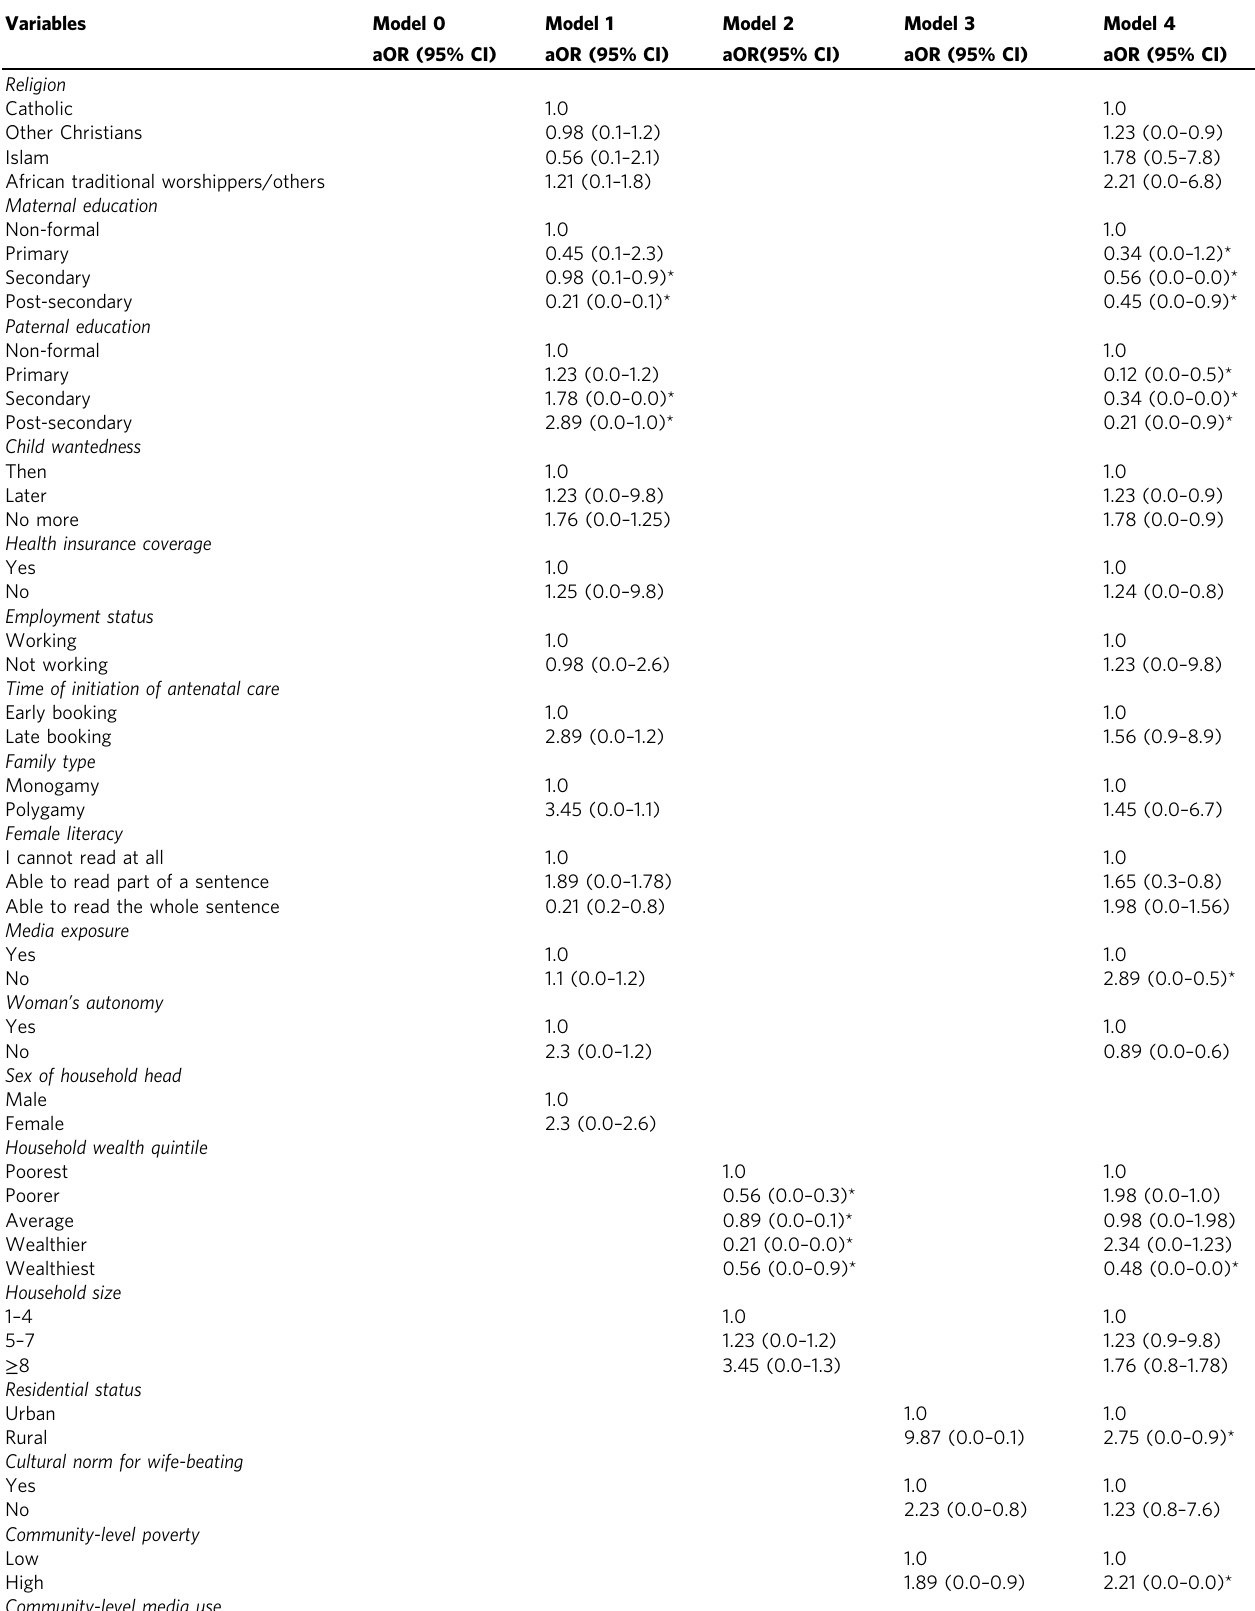
Table 2 Predictors of non-utilisation of health facility delivery among childbearing women in